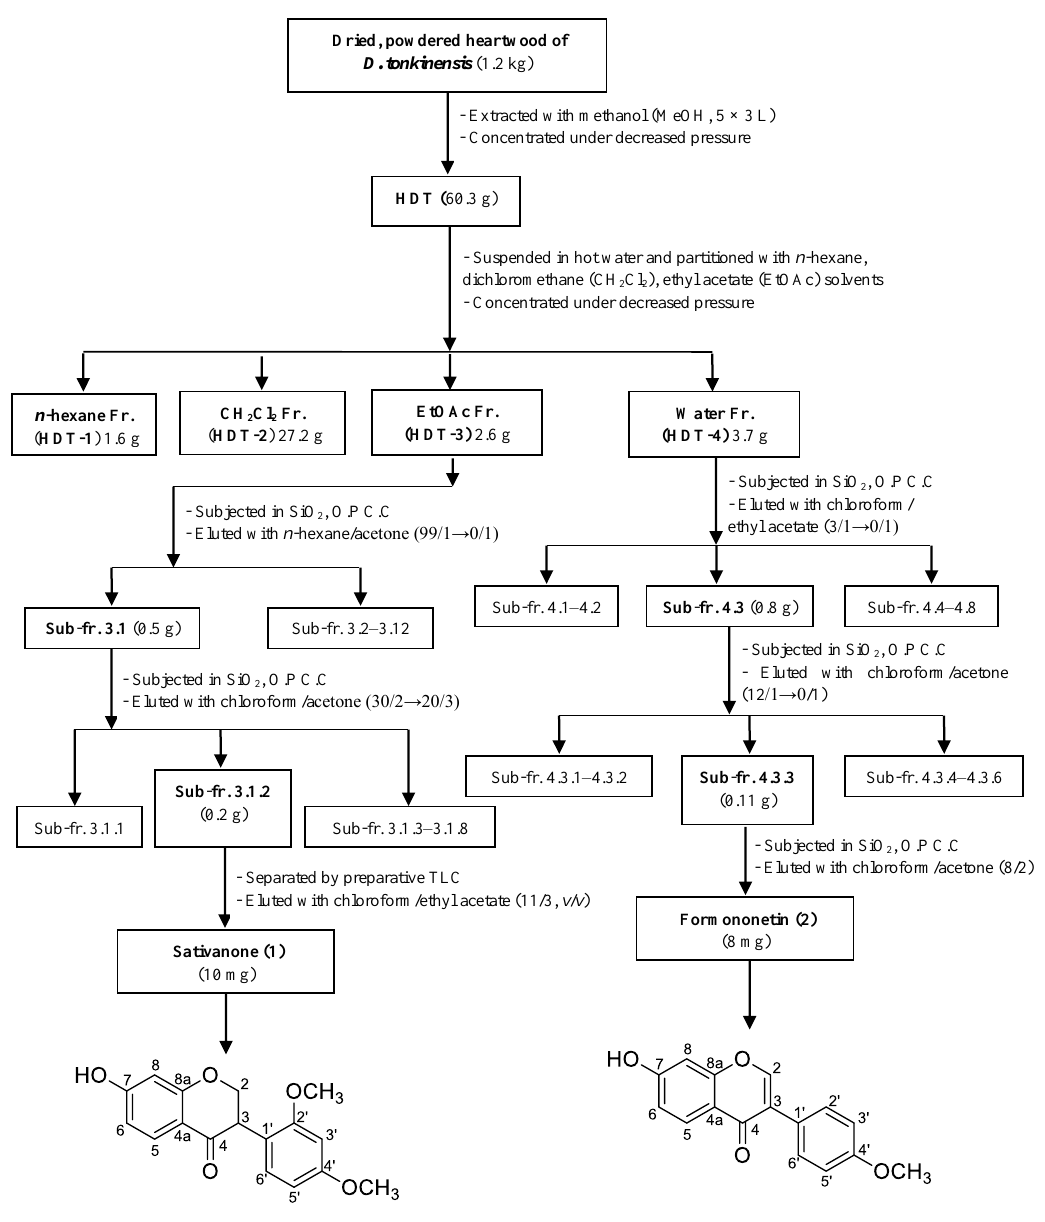
Figure 3. Flowchart for the isolation and identification of active inhibitors from the heartwood of Dalbergia tonkinensis (HDT); Fr. (fraction).